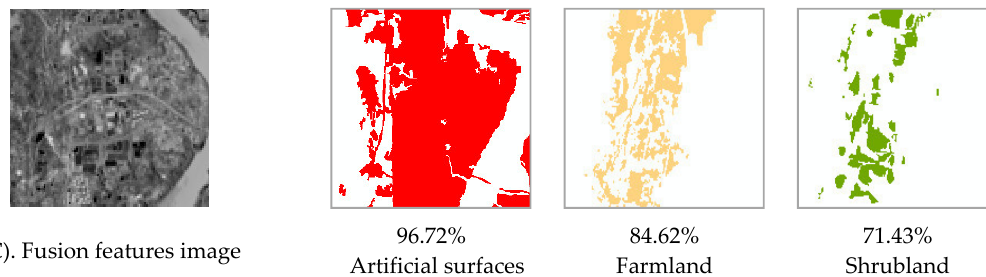
Table 4. Comparison of classification accuracies for different land types.